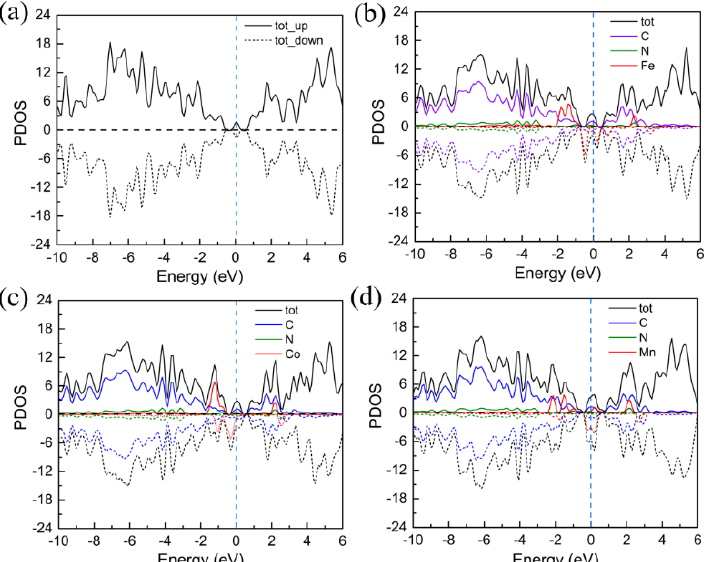
Figure 2. The projected density of states (PDOS) of pristine graphene ( a ) and metal-N 4 @graphene (metal = Fe ( b ), Co ( c ), and Mn ( d )). The solid and dashed lines represent spin-up and spin-down components of PDOS, respectively. The vertical blue dashed lines represent the Fermi energy level.